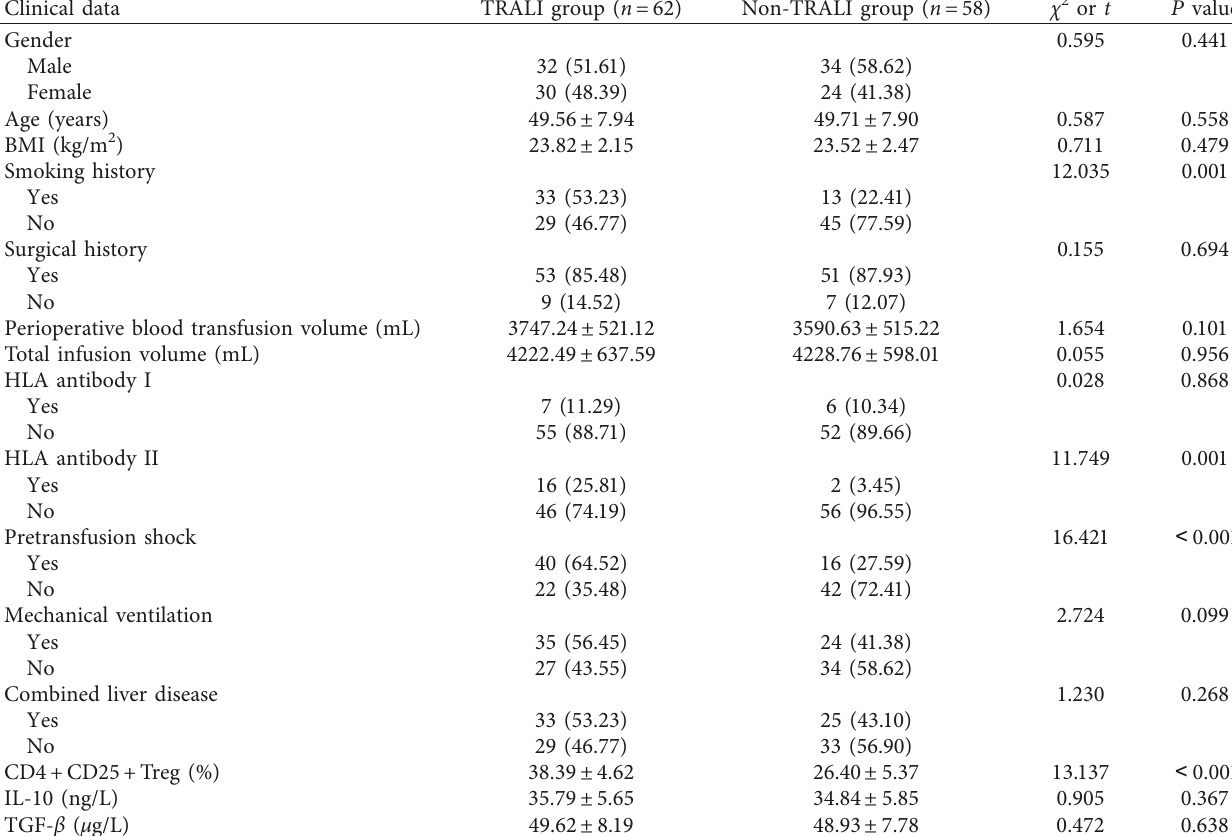
Table 1: Comparison of clinical data between TRALI group and non-TRALI group (n (%), x ± s ). Clinical data